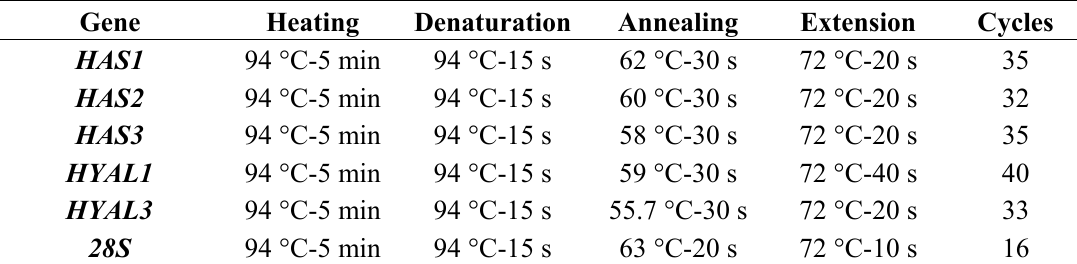
Table 4. RT-PCR conditions.